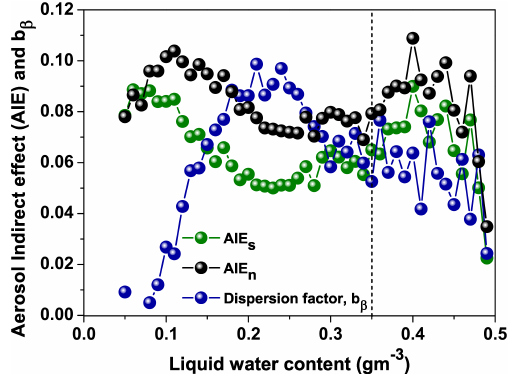
Figure 5. Aerosol indirect effect estimates using AIE n , AIE s , and the dispersion factor for the LWC ranges are represented. Green, black, and blue lines correspond to AIE s , AIE n , and dispersion fac- tor